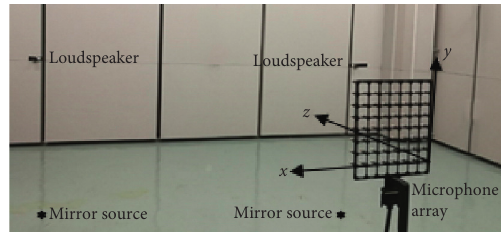
Figure 4: Experimental